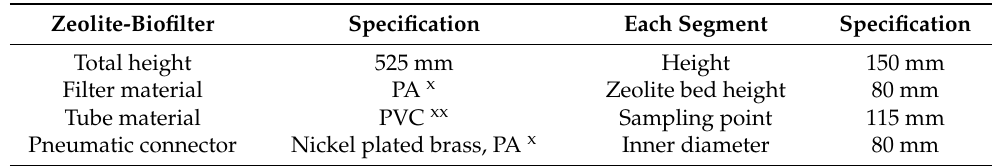
Table 2. Specifications of the used Anammox